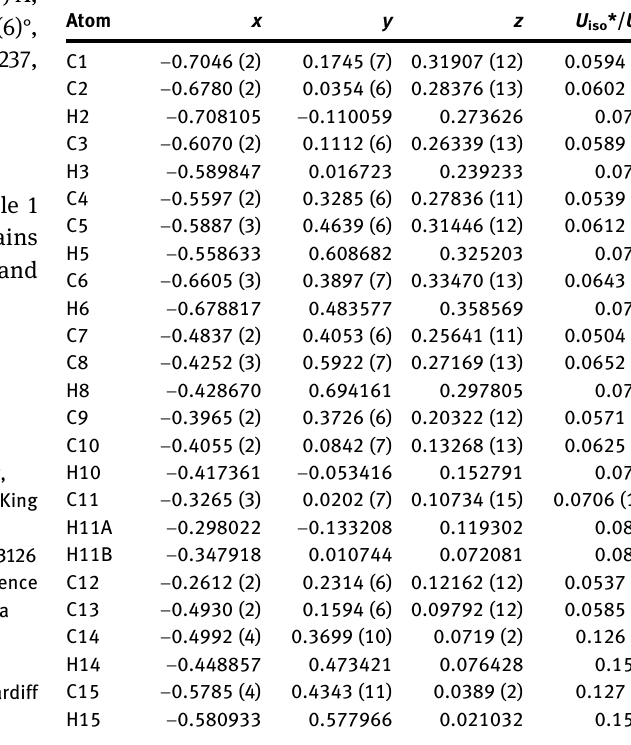
Table  : Fractional atomic coordinates and isotropic or equivalent isotropic displacement parameters (Å 